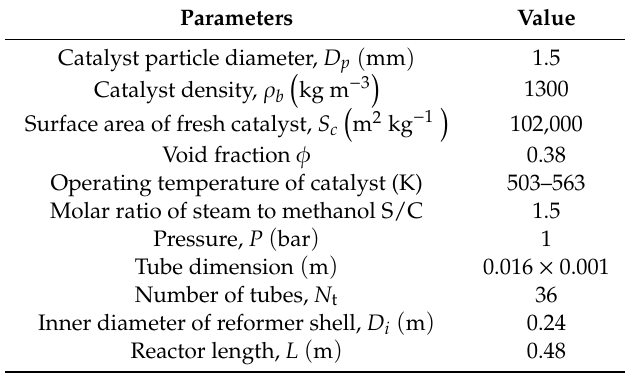
Table 4. Reactor specification and operating conditions of the reformer in this study.